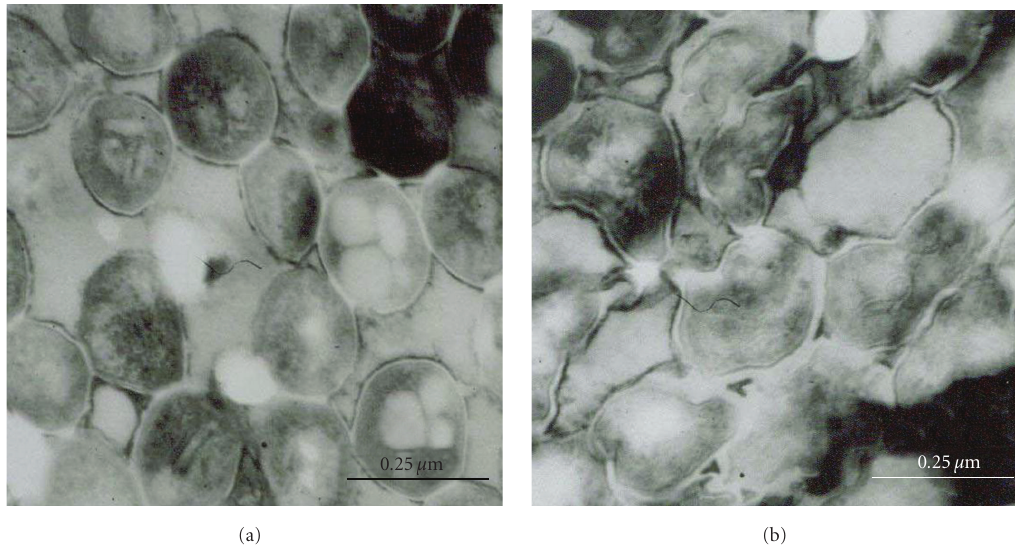
Figure 3: TEM images of M. tuberculosis H37Rv exposed to compound 3 at MIC for 24h (b) and control (a). Plasma membrane (pm). Cell wall (cw). Mesosome (m). Bar: